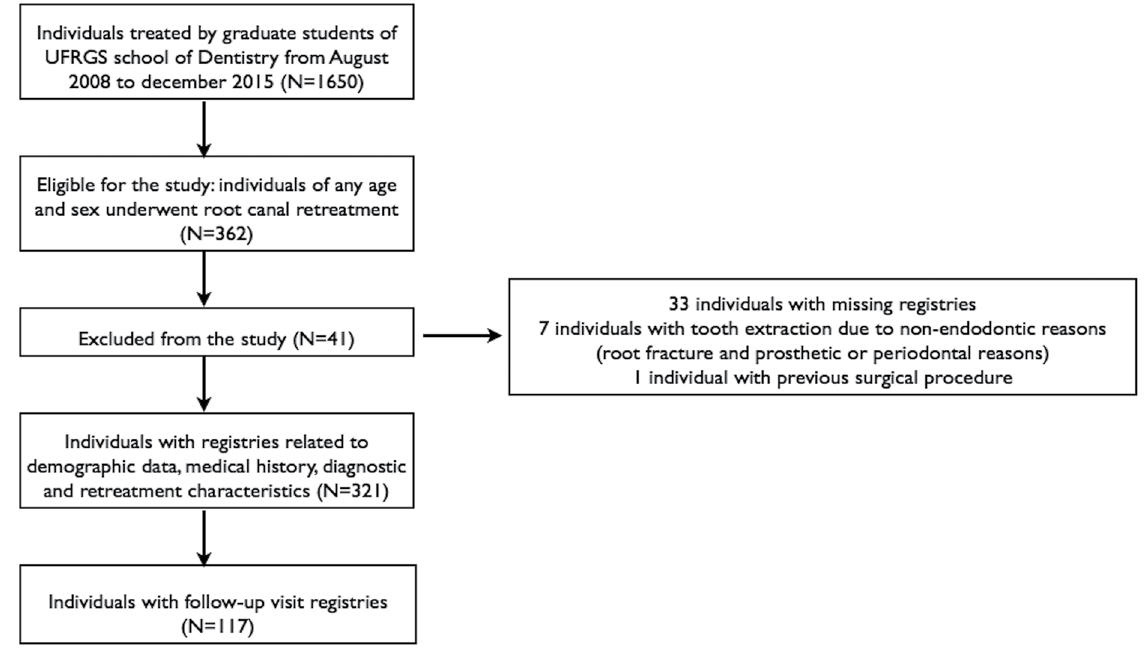
Figure 1- Flow chart of the study sample